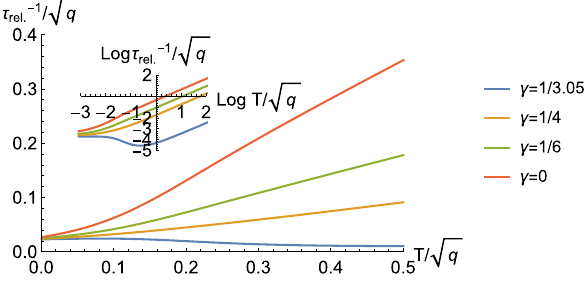
Fig. 6 Relaxation rate τ − 1 and its logarithmic form as the function of rel . T for different couplings. We have set q = 1